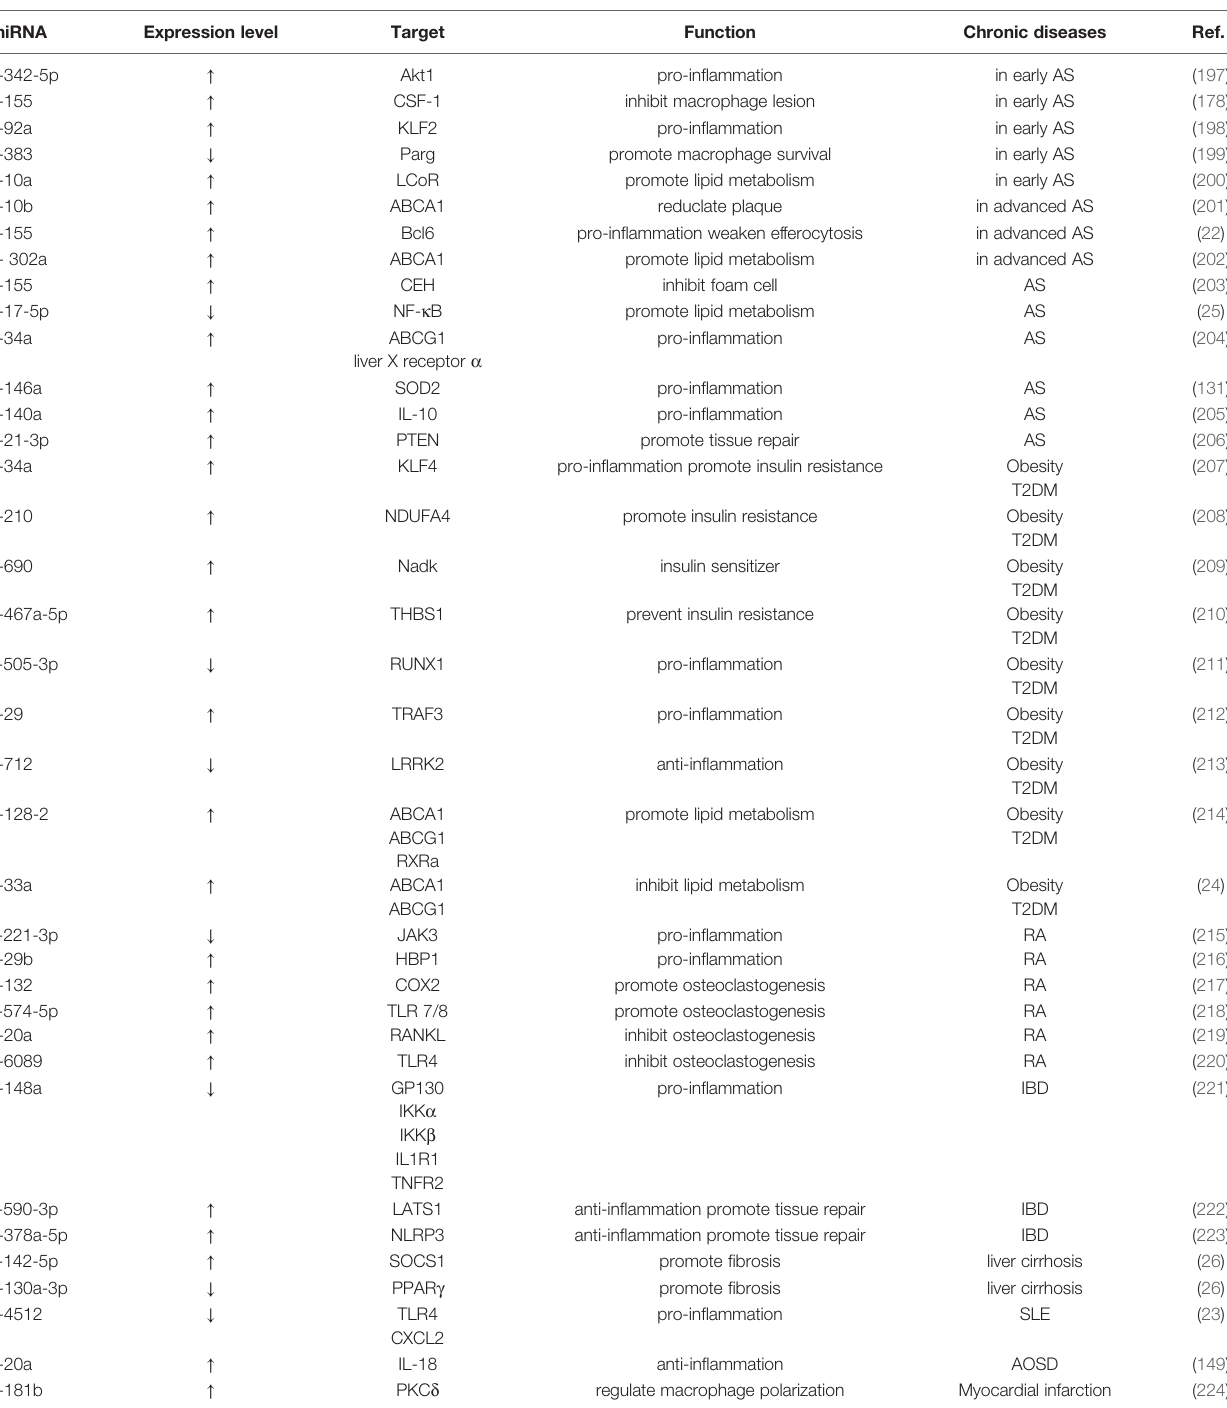
TABLE 2 | miRNAs regulate macrophage-involved chronic